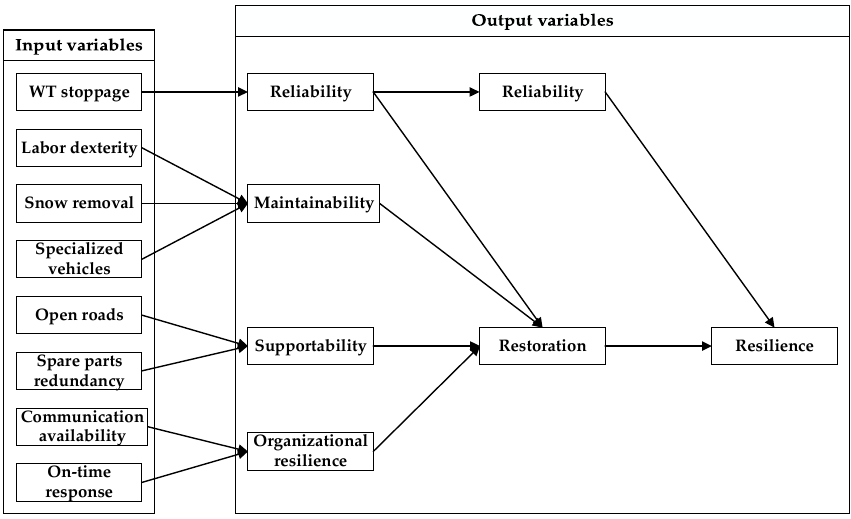
Figure 1. Input and output variables of the resilience of WFs.